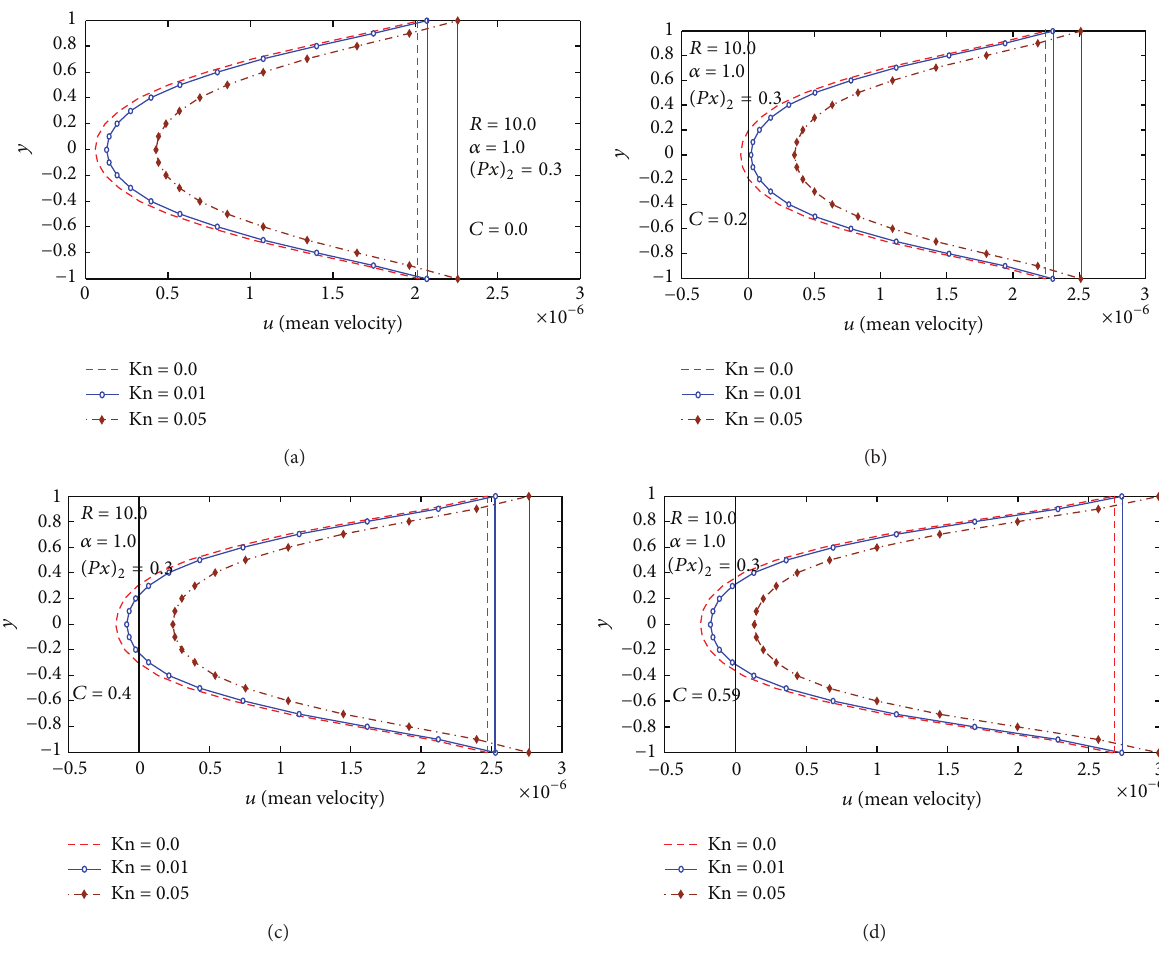
Figure 4: (a) Mean velocity distribution at 𝐶 = 0.0 , 𝛼 = 1.0 , (𝜕𝑝/𝜕𝑥) 2 = 0 . 3, and 𝑅 = 10 . (b) Mean velocity distribution at 𝐶 = 0.2 , 𝛼 = 1.0 , (𝜕𝑝/𝜕𝑥) = 0 . 3, and 𝑅 = 10 . (c) Mean velocity distribution at 𝐶 = 0.4 , 𝛼 = 1.0 , (𝜕𝑝/𝜕𝑥) 2 𝐶 = 0.59 , 𝛼 = 1.0 , (𝜕𝑝/𝜕𝑥) = 0 . 3, and 𝑅 = 10 2